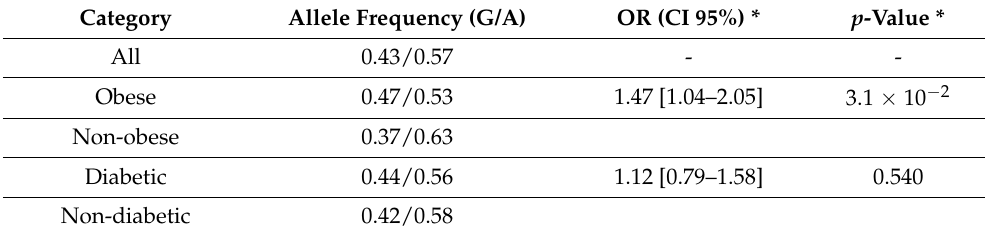
Table 2. Results of allelic association of rs4846914 with obesity status and diabetes